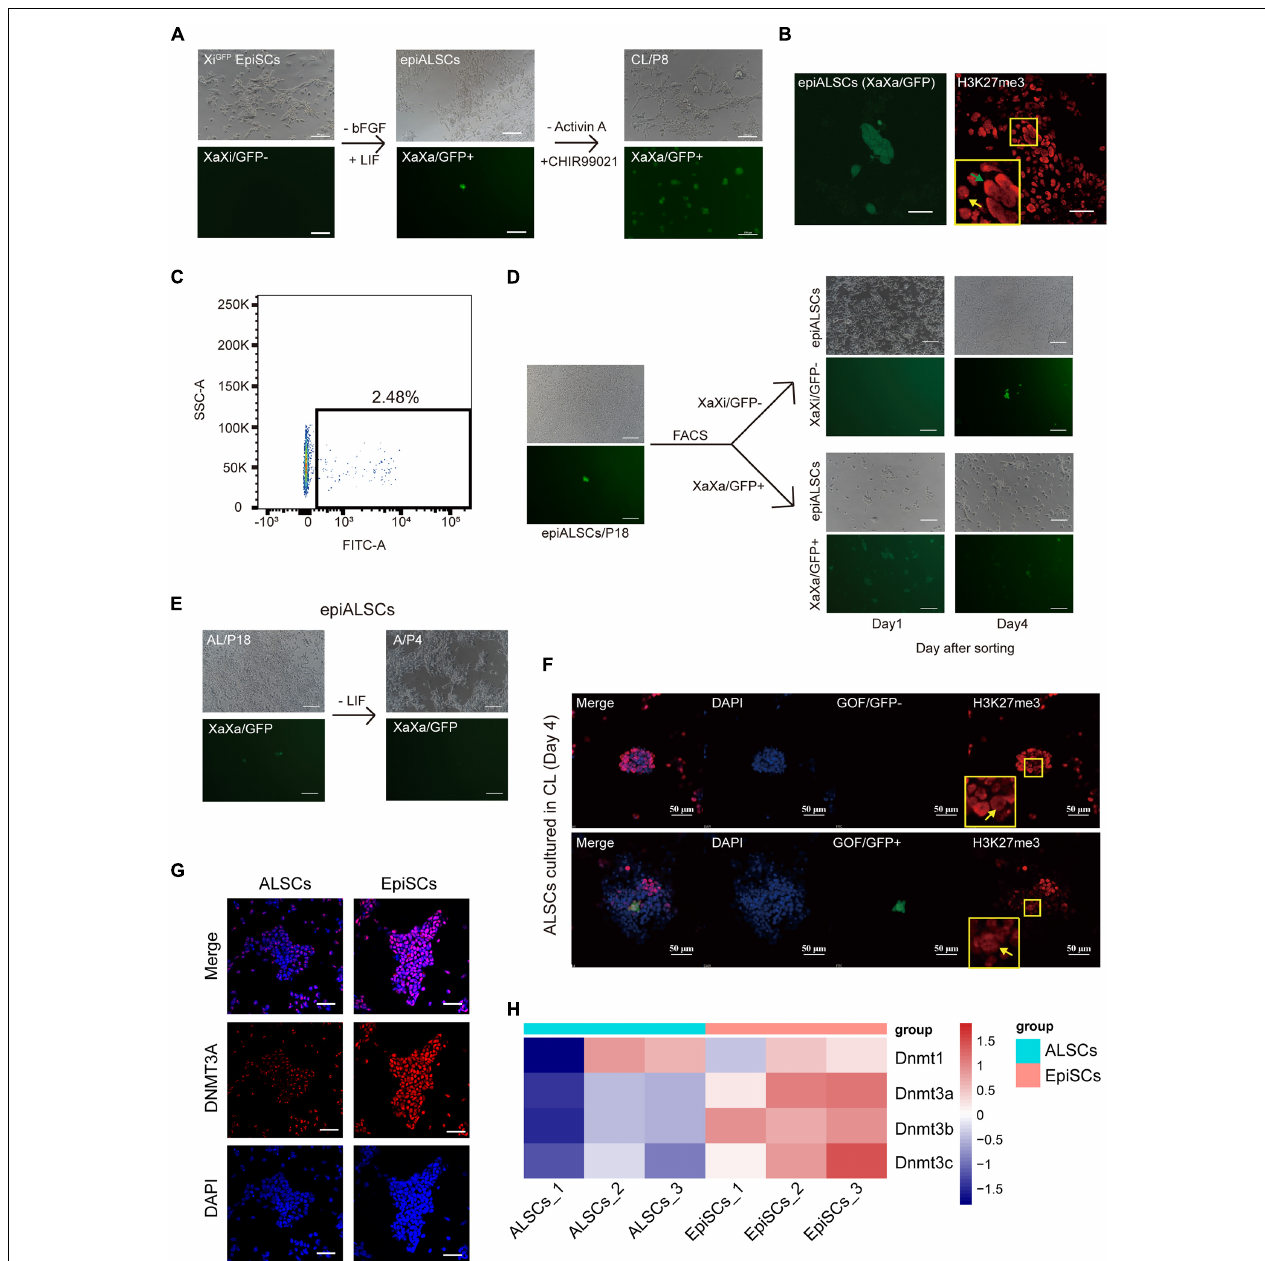
FIGURE 5 | Conversion of Xi GFP EpiSCs to rESCs. (A) Morphological changes and rESC induction process of Xi GFP EpiSCs. Scale bars, 100 µ m. (B) Immunostaining of H3K27me3 in epiALSCs. Scale bars, 50 µ m. (C) Fluorescence-activated cell sorting analysis of epiALSCs, GFP + cells were Xa GFP epiALSCs. (D) Morphological changes and X chromosome change process from isolated XaXa-epiALSCs and XaXi-epiALSCs. Yellow arrow shows XaXi epiALSCs, green arrow shows XaXa epiALSCs. Scale bars, 100 µ m. (E) Morphological changes and X chromosome inactivation process of epiALSCs placed in Act A-alone medium for four passages. Scale bars, 100 µ m. (F) Immunostaining of H3K27me3 with GOF/GFP in ALSCs after having been placed in CL medium for 4 days. Yellow arrows show XaXa epiALSCs. Scale bars, 50 µ m. (G) Immunostaining of DNMT3A in ALSCs and EpiSCs. Scale bars, 50 µ m. (H) Heat map showing the scaled expression of DNA methylation-related